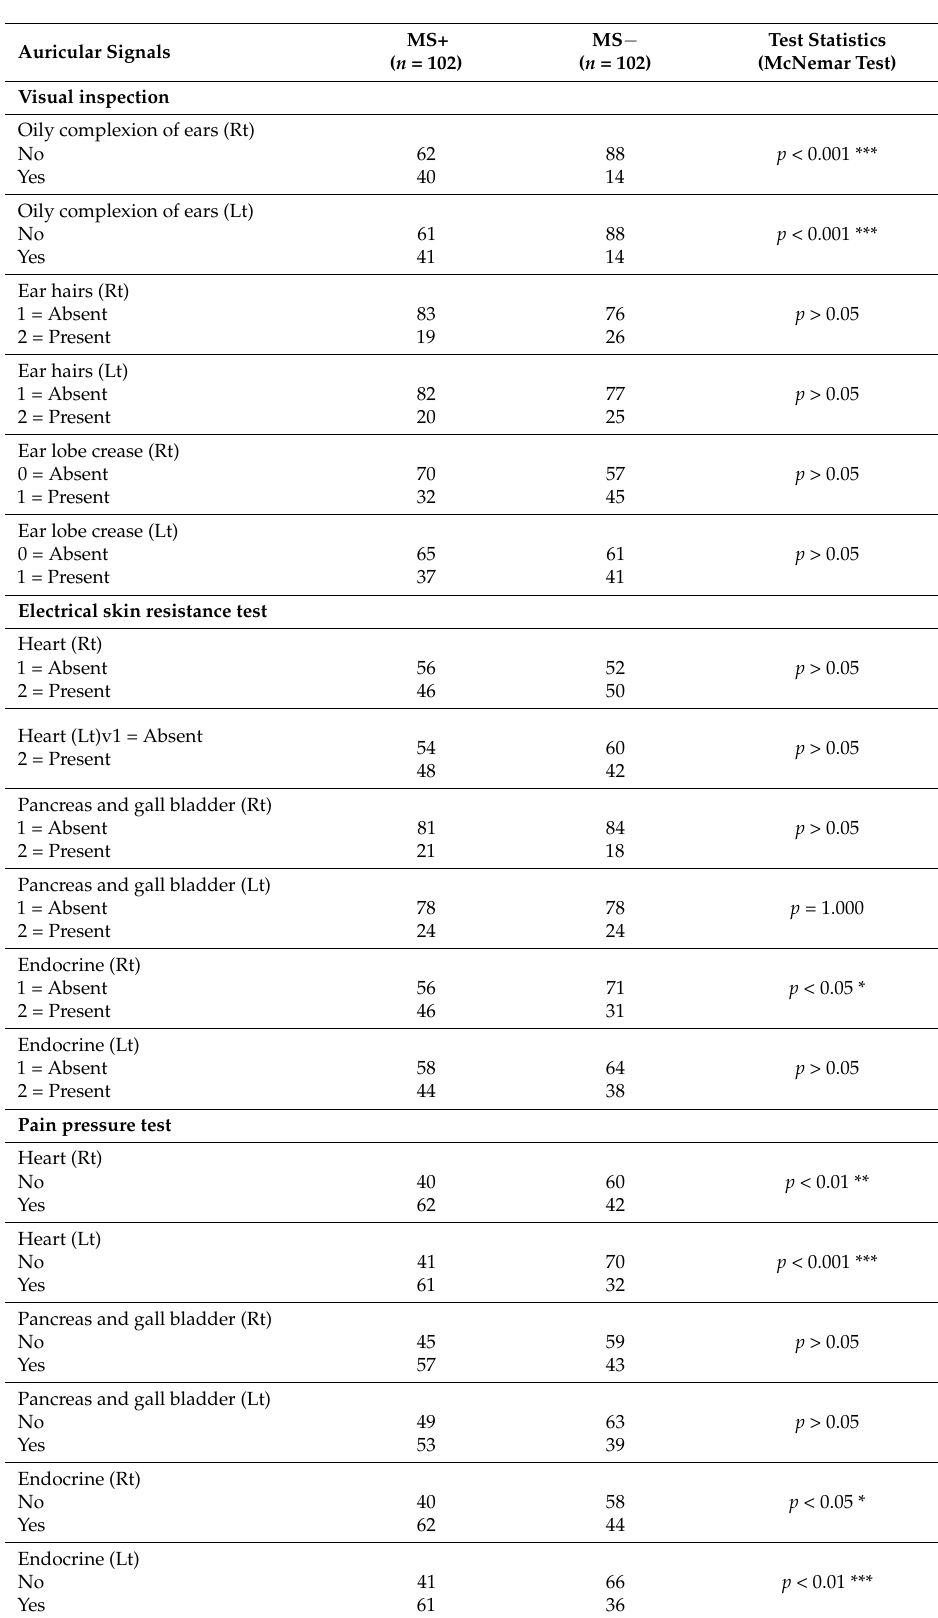
Table 2. Auricular signals between cases and